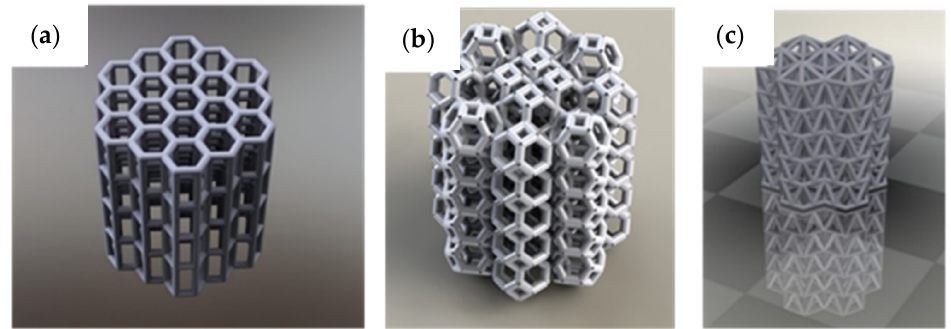
Figure 3. ( a ) Hexagonal with rectangular cell; ( b ) Truncated octahedron; ( c ) Icosahedron.